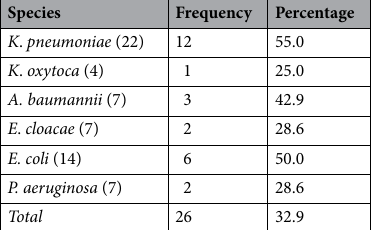
Table 7. The magnitude of ESBLs Production in Gram-negative